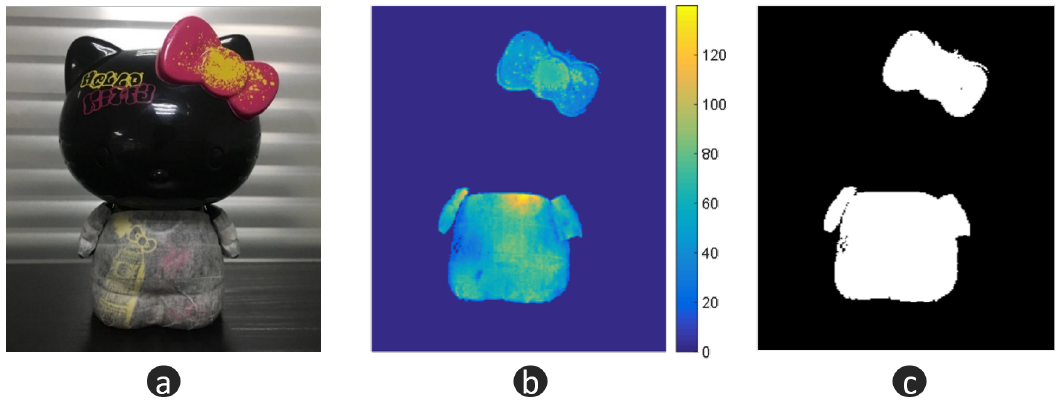
Figure 9. Measuring object and intermediate data. ( a ) measuring object; ( b ) quality map from FPP; ( c ) binary mask for data fusion.